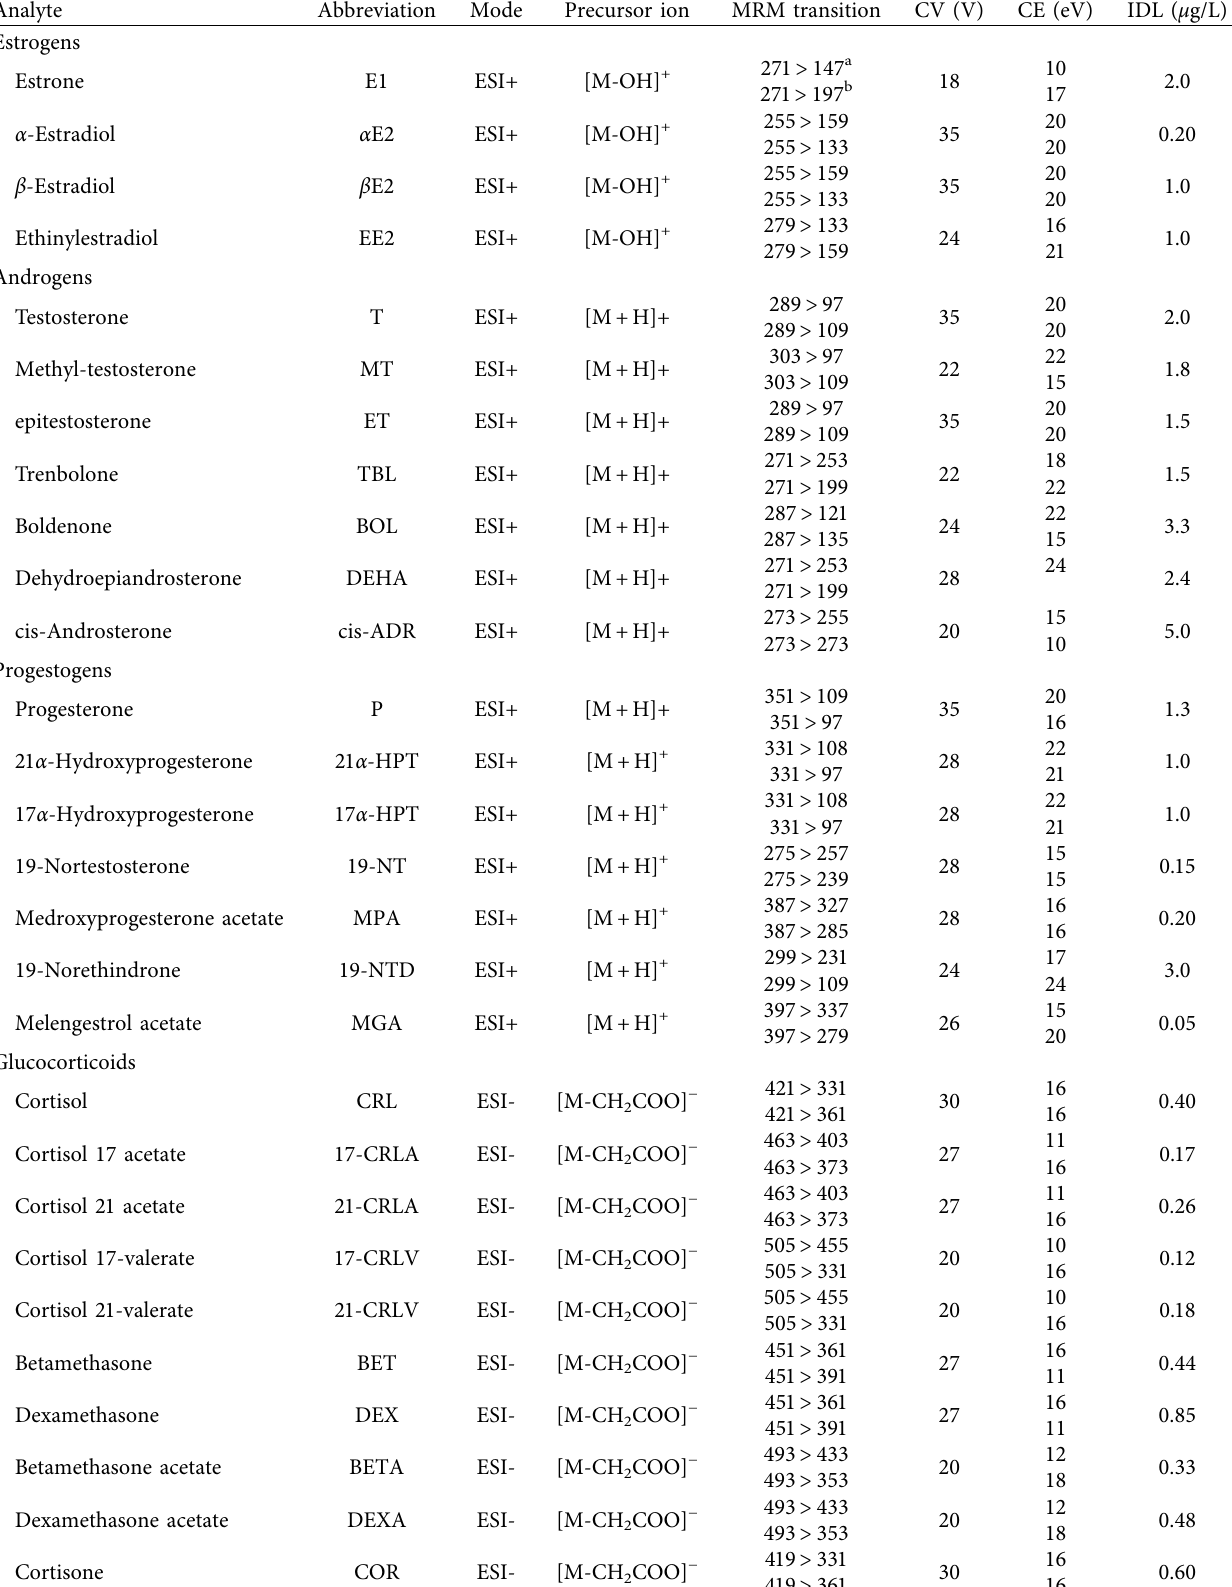
Table 1: Optimized instrumental and MRM conditions of the target